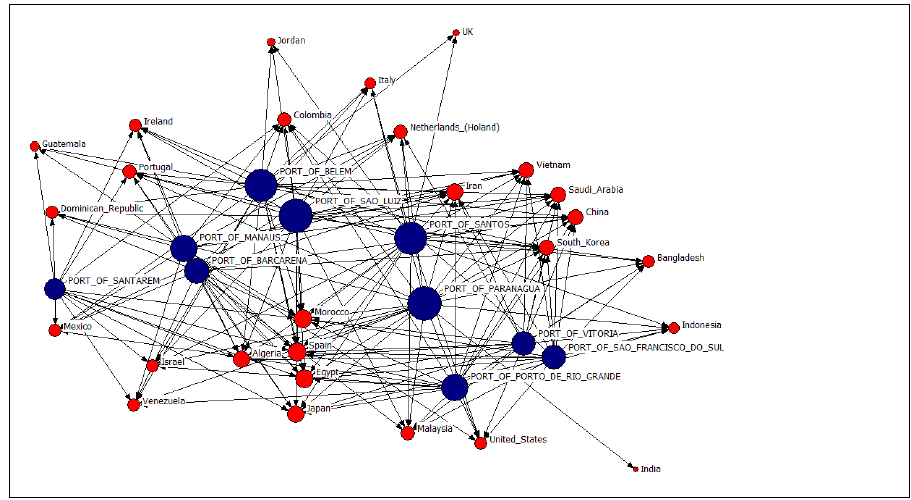
Figure 5. Degree centrality network connecting countries (red nodes) and ports (blue nodes). Table 1. Centrality